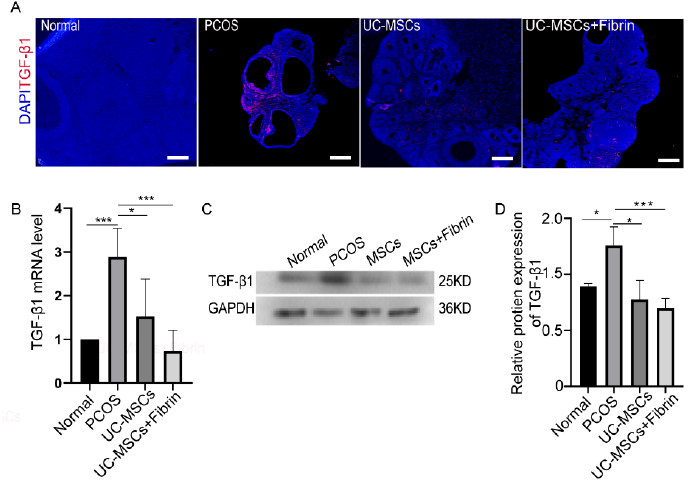
Figure 6. Immunohistochemical analysis and expression of transforming growth factor- β 1 (TGF- β 1). ( A ) Immunofluorescence analysis. TGF- β 1 expression was indicated in red and nuclei in blue color; scale bar, 100 µ m. ( B ) The relative expression of TGF- β 1 RNA was quantified by RT-PCR. ( C ) TGF- β 1 protein was detected by western blotting. ( D ) Relative protein expression of TGF- β 1 was quantified by Image J 1.52a software and normalized to the GAPDH value. GAPDH was used as internal control (* p < 0.5, ** p < 0.01, *** p <